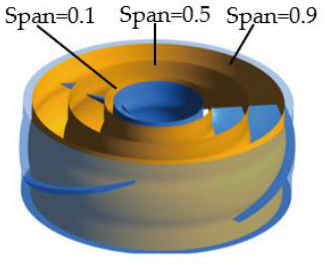
Figure 10. Diagram of different spans.